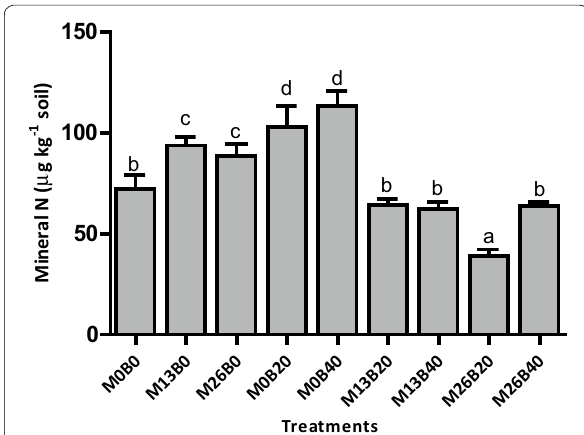
Fig. 5 Effect of treatment on mineral N during the incubation of sandy soils amended with cow manure (M), biochar (B) and B–M mixtures over 56 days. Same letter(s) above the bars indicate no significant difference between treatments at p represent standard error of the mean (n M rates at 0, 13 and 26 tons ha − 1 respectively. B0, B20 and B40 are B rates at 0, 20 and 40 tons ha − 1 , respectively